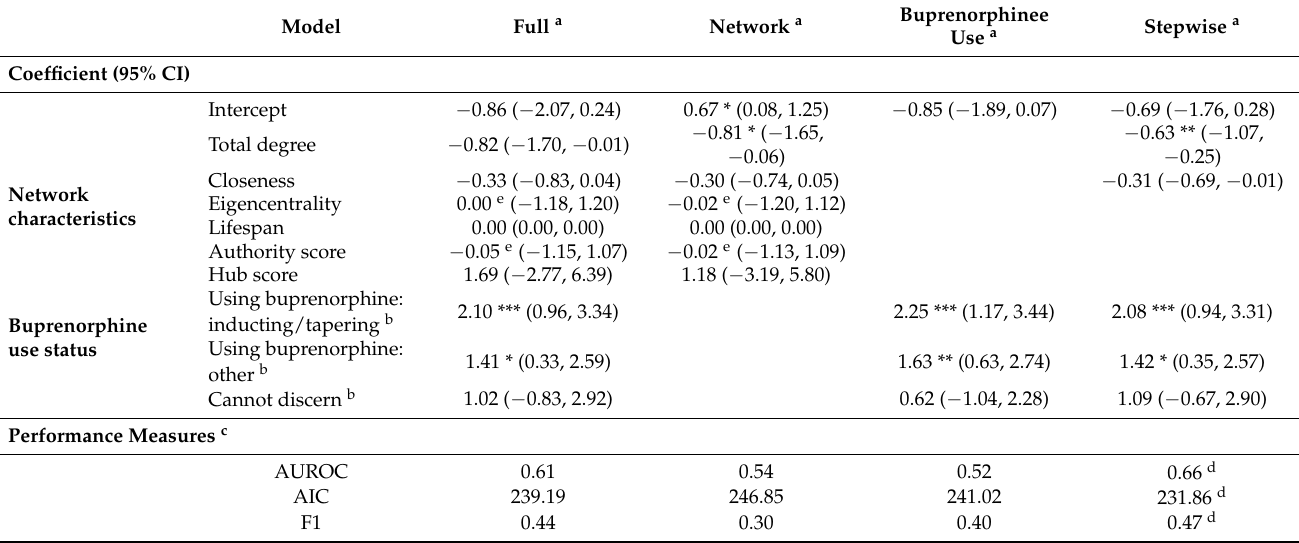
Table 2. Model coefficients and performance measures for each model predicting the likelihood of